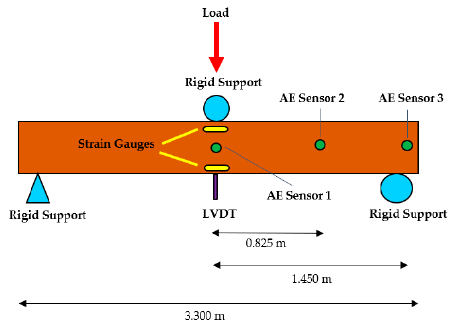
Figure 3. Schematic view of the linear variable differential transformer (LVDT) and the sensors used.